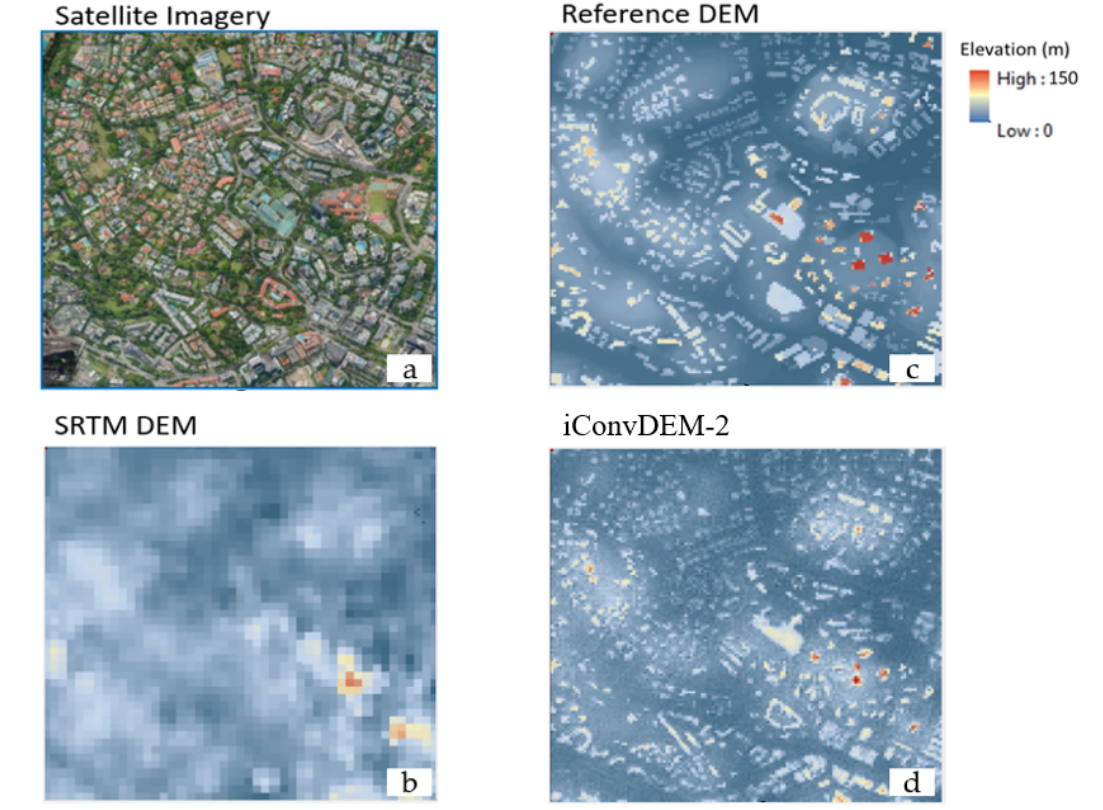
Figure 11. Plots at sub-area within the test site in Orchard Road area of: ( a ) satellite image, ( b ) refer- ence DEM, ( c ) SRTM DEM and ( d )